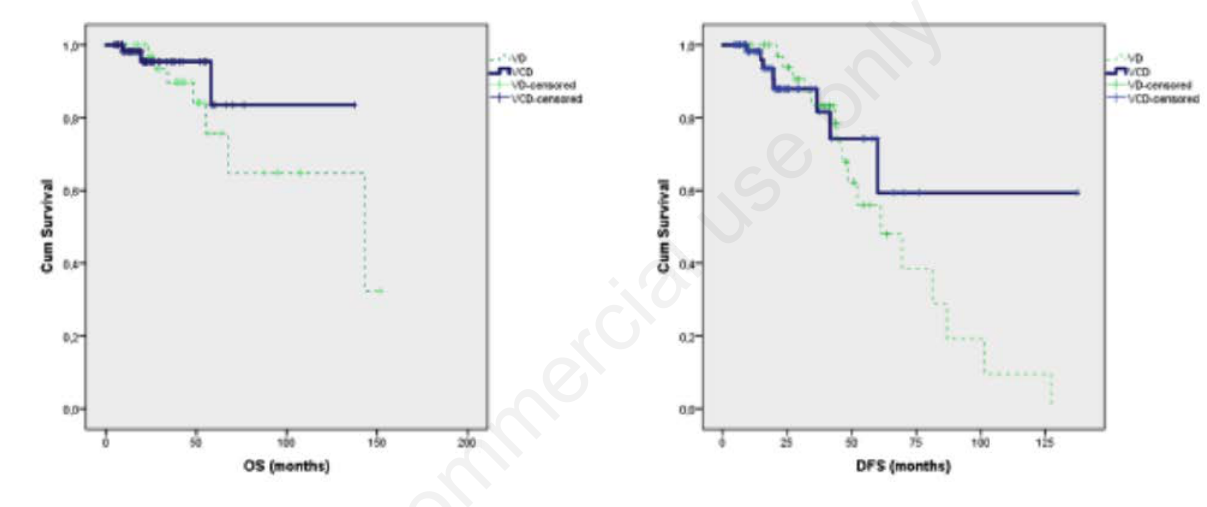
Figure 3. The overall survival (P=0.47) and progression free survival (p=0.40) for VD and VCD